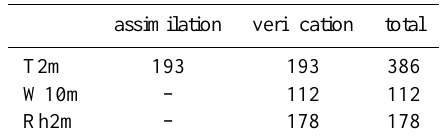
Table 1. Number of stations distributed over the territory, according to the parameter. Fig. 2. Piemonte high resolution distribution for temperature sensors used for verification. The red dotes indicate stations below 700 m, the yellow triangles above.